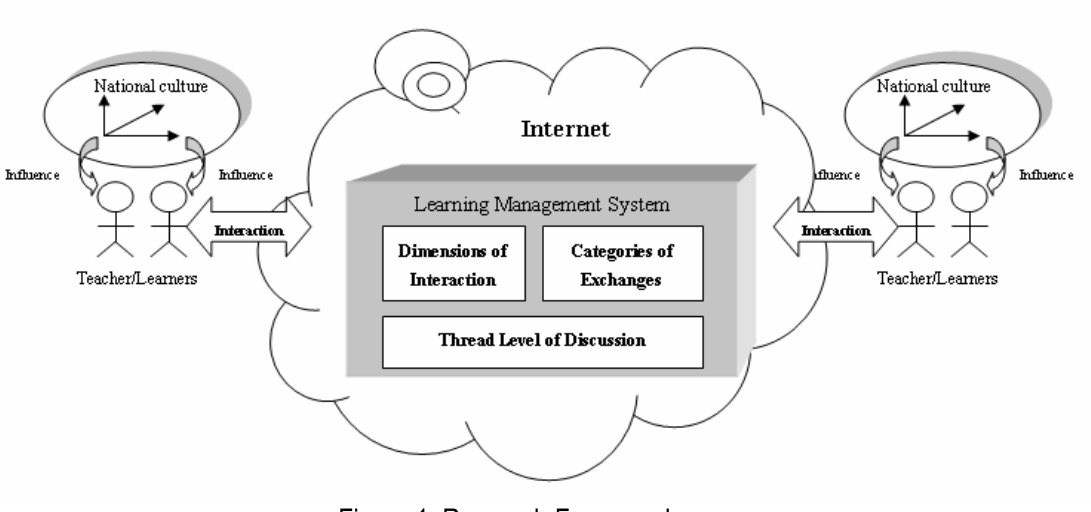
Figure 1: Research